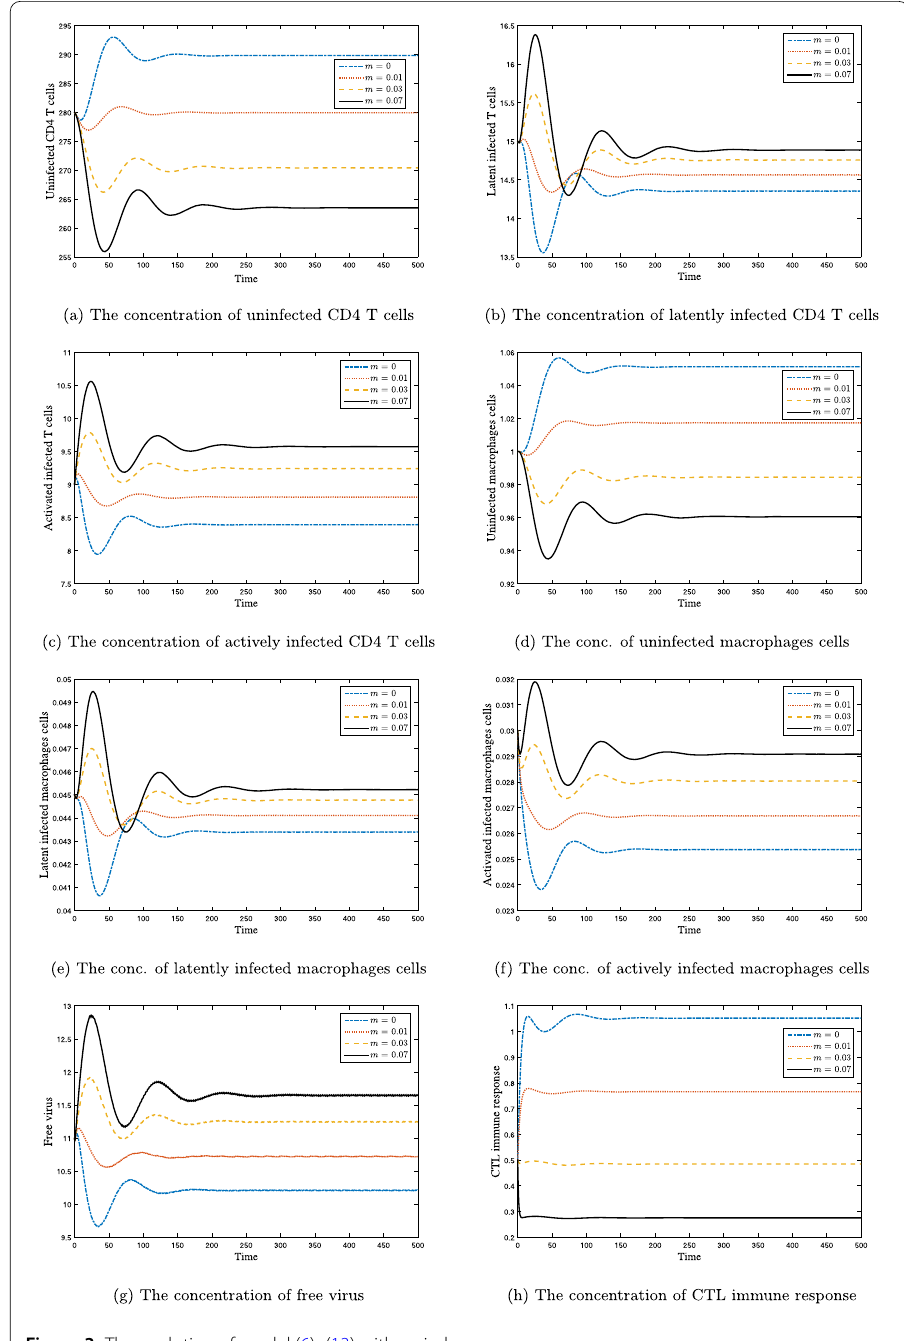
Figure 3 The evolution of model (6)–(13) with varied m